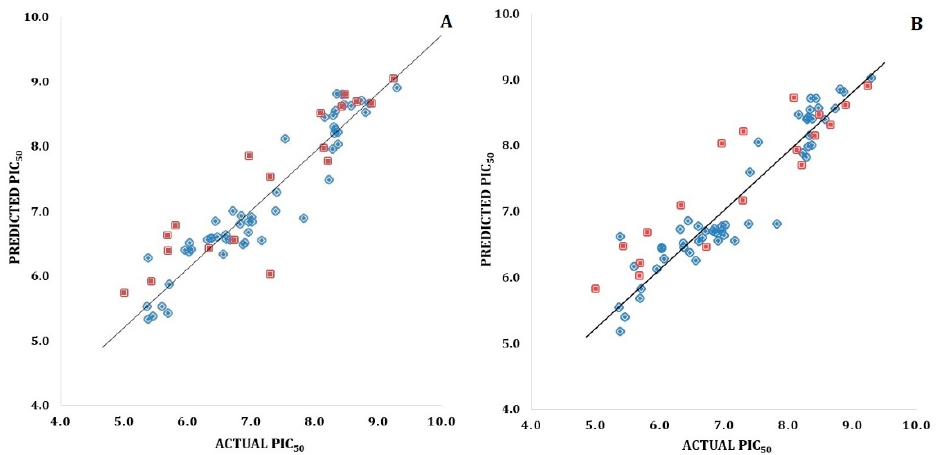
Figure 5. ( A ) Scatter plot for the selected CoMFA model; ( B ) Scatter plot for the selected CoMSIA model; the plot shows the actual pIC 50 versus predicted pIC 50 activity of the training and test sets; the training set compounds are represented as blue diamonds; the test set compounds are represented as dark red squares.